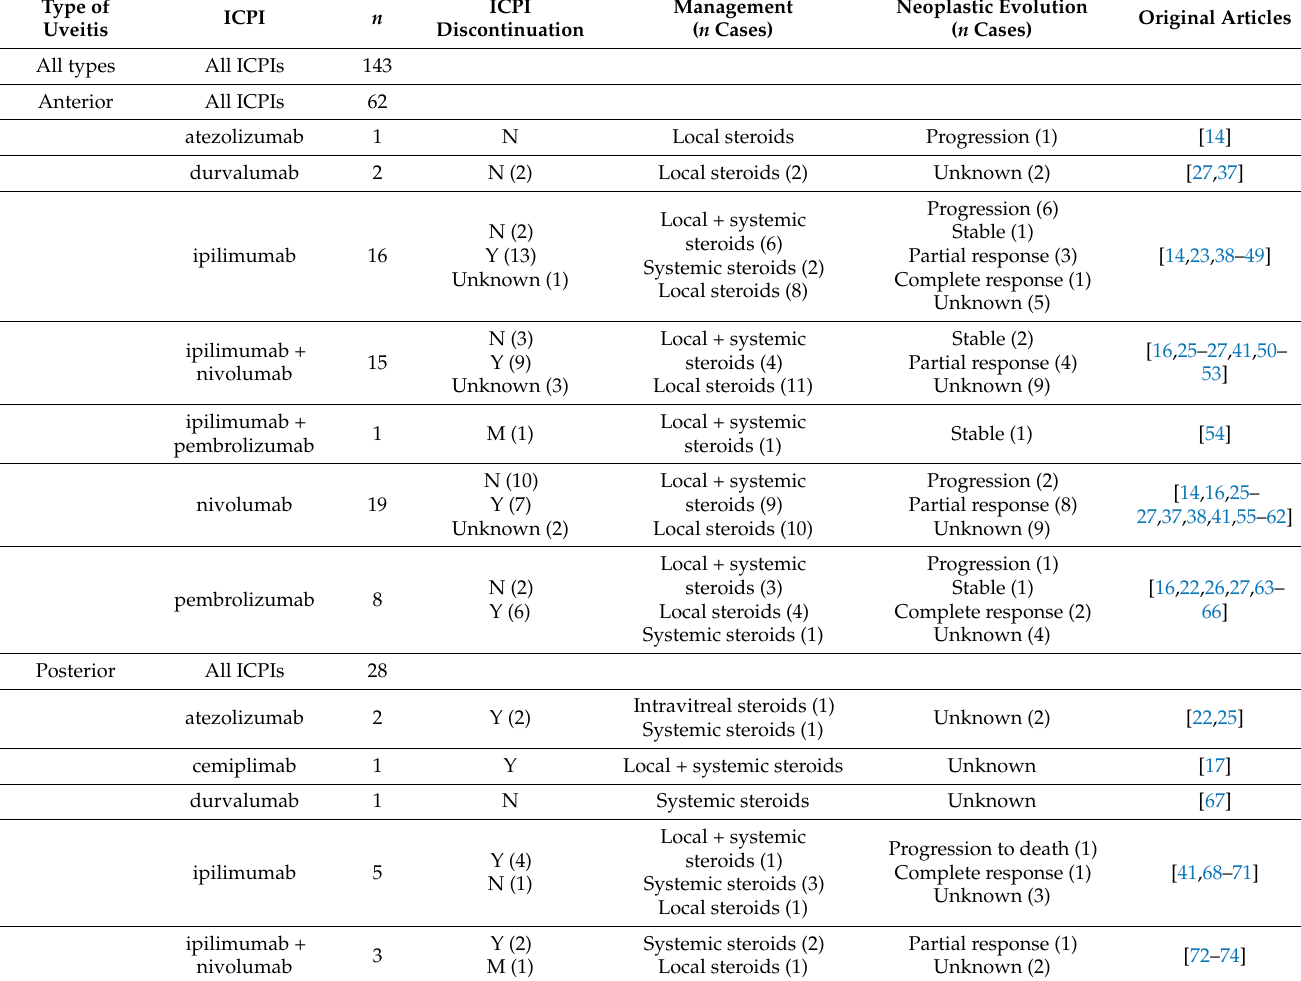
Table 7. Reported cases of ICPI-induced